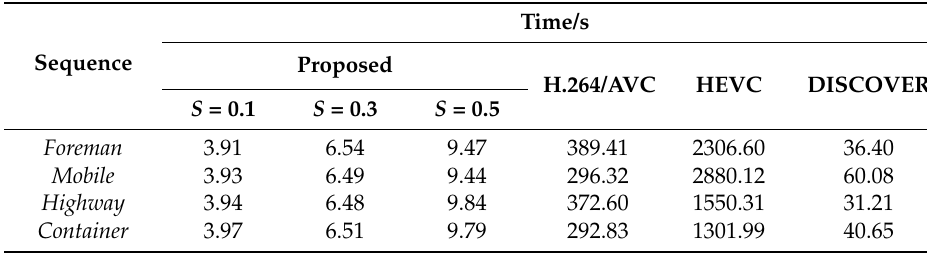
Table 1. The time to encode 100 frames of various video coding